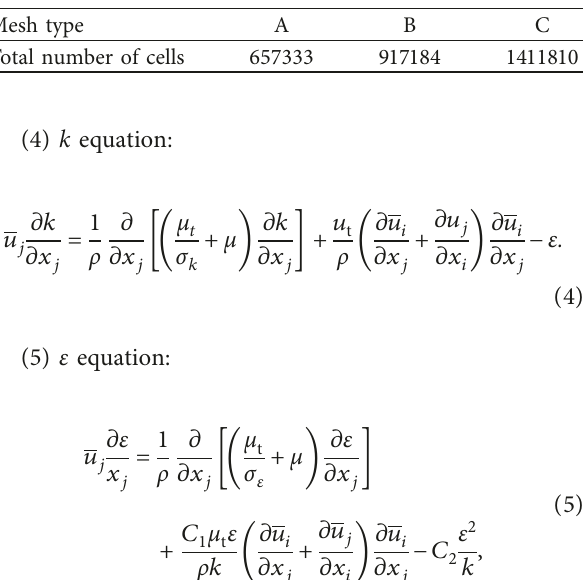
Figure 3: Parameters of the shaft blowing and exhausting longitudinal ventilation system. Table 1: Description of mesh in modeling.